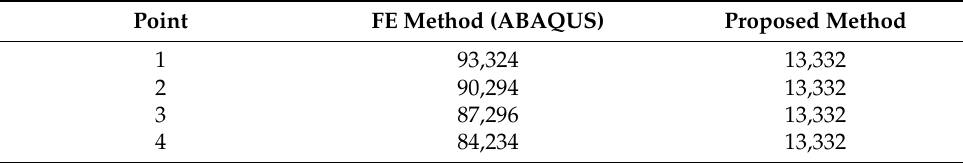
Table 2. DOFs’ comparison of two models.